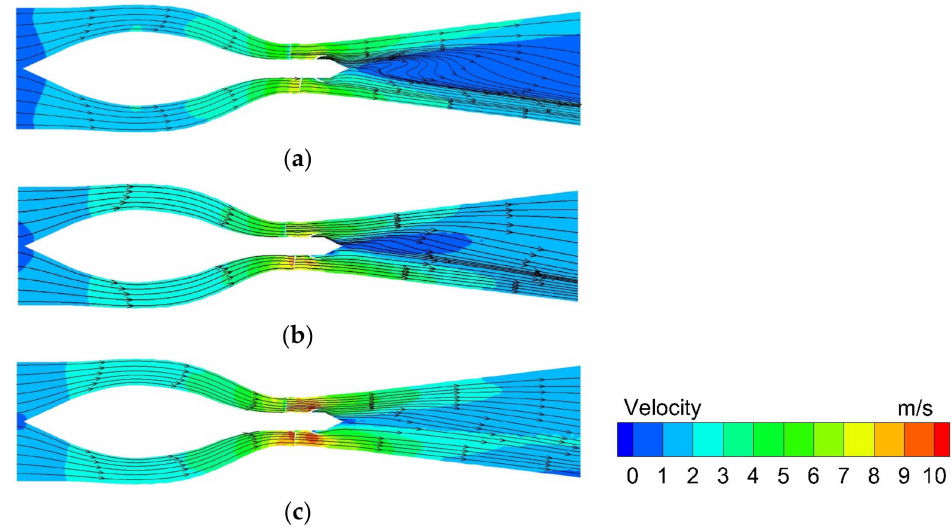
Figure 8. Streamlines and velocity contour on cross section in shaft front-positioned tubular pump